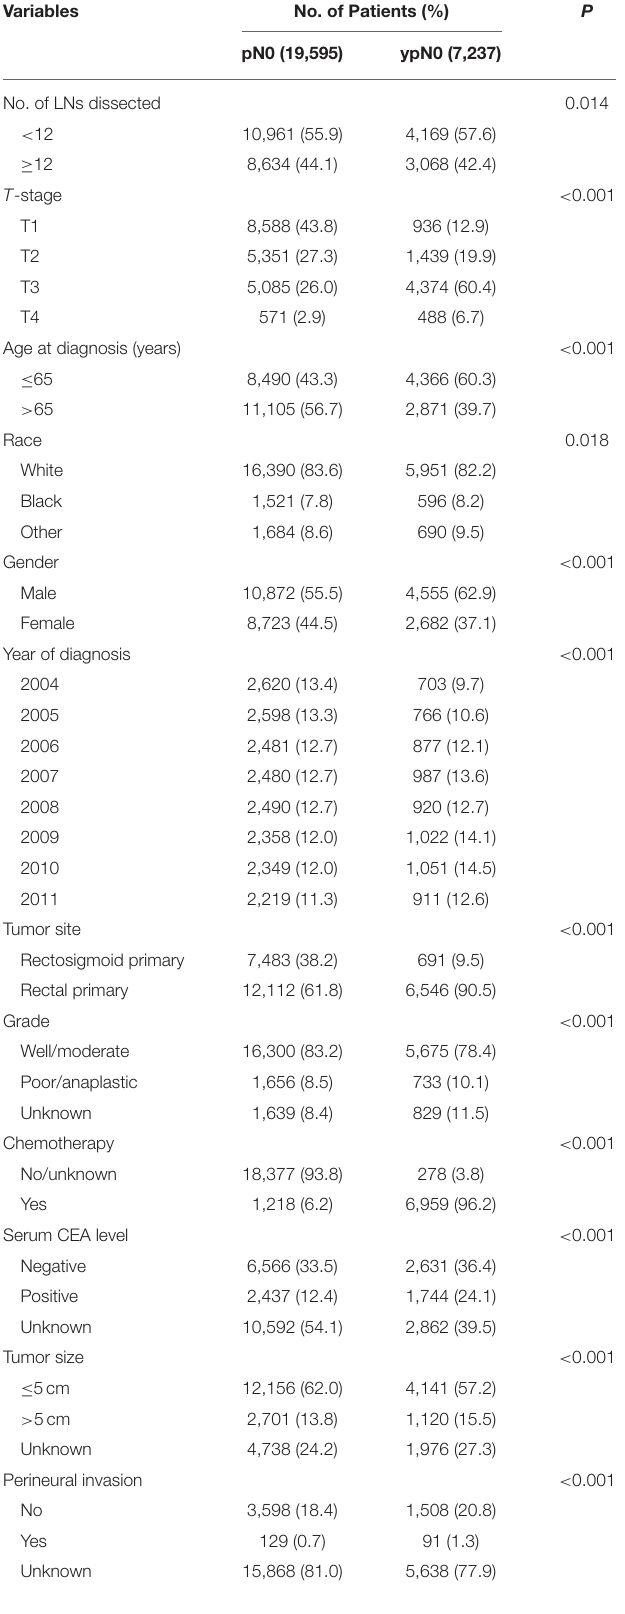
TABLE 1 | Patients’ baseline characteristics before